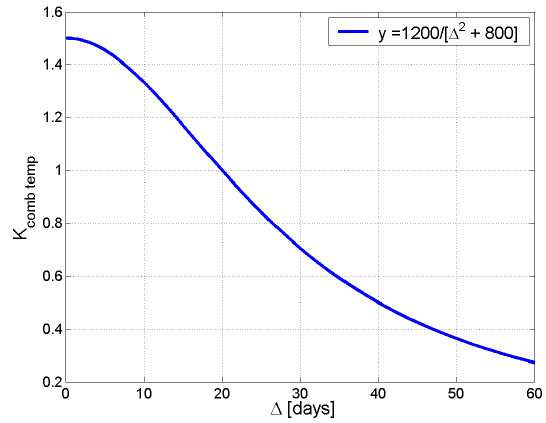
Figure 6. Weighting factor for multi-temporal